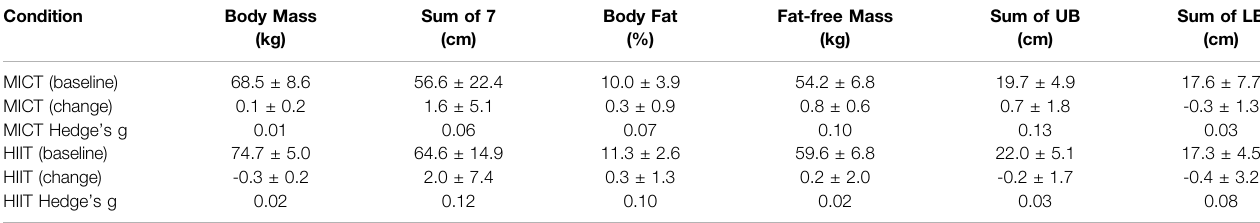
TABLE 3 | Baseline and pre-to post-training change in body composition parameters for the MICT and HIIT groups. Condition